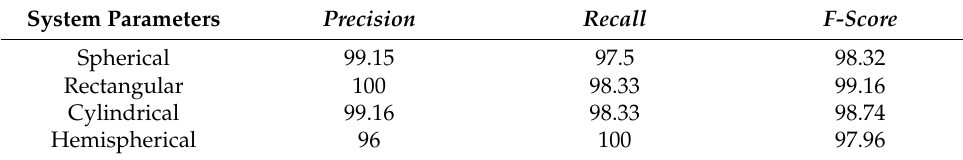
Table 3. Statistical results obtained from RelationNet